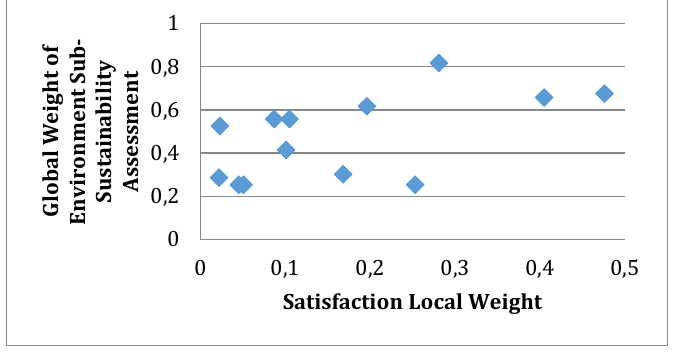
Figure 27: Global weight vs. satisfaction local weight of environment sub-sustainability